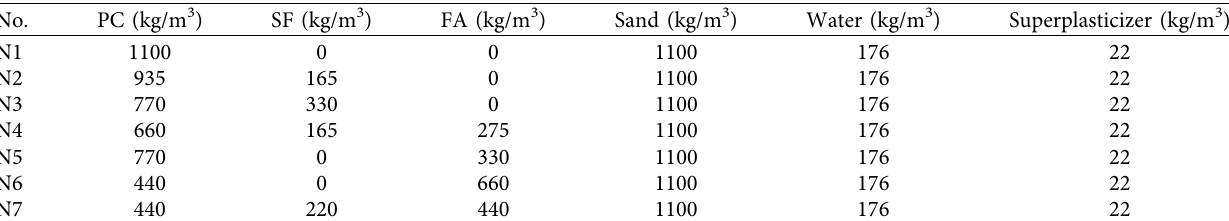
Table 2: Mixture proportions of UHSC.